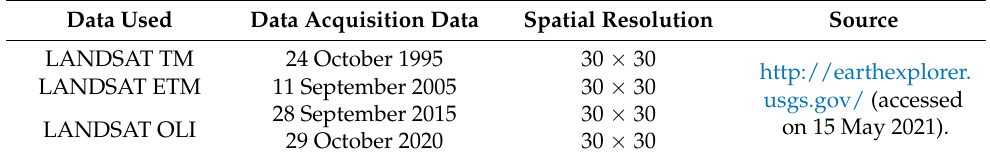
Table 1. Data used and their source.